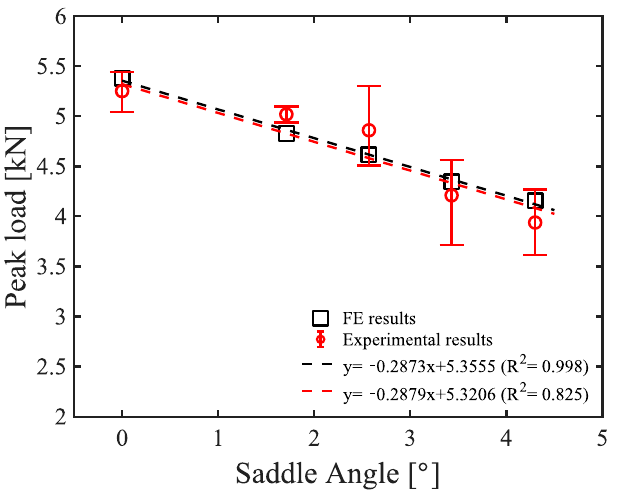
Figure 9. Comparison of the FE results, fitting equation, and experiment results regarding peak load vs. saddle angle.